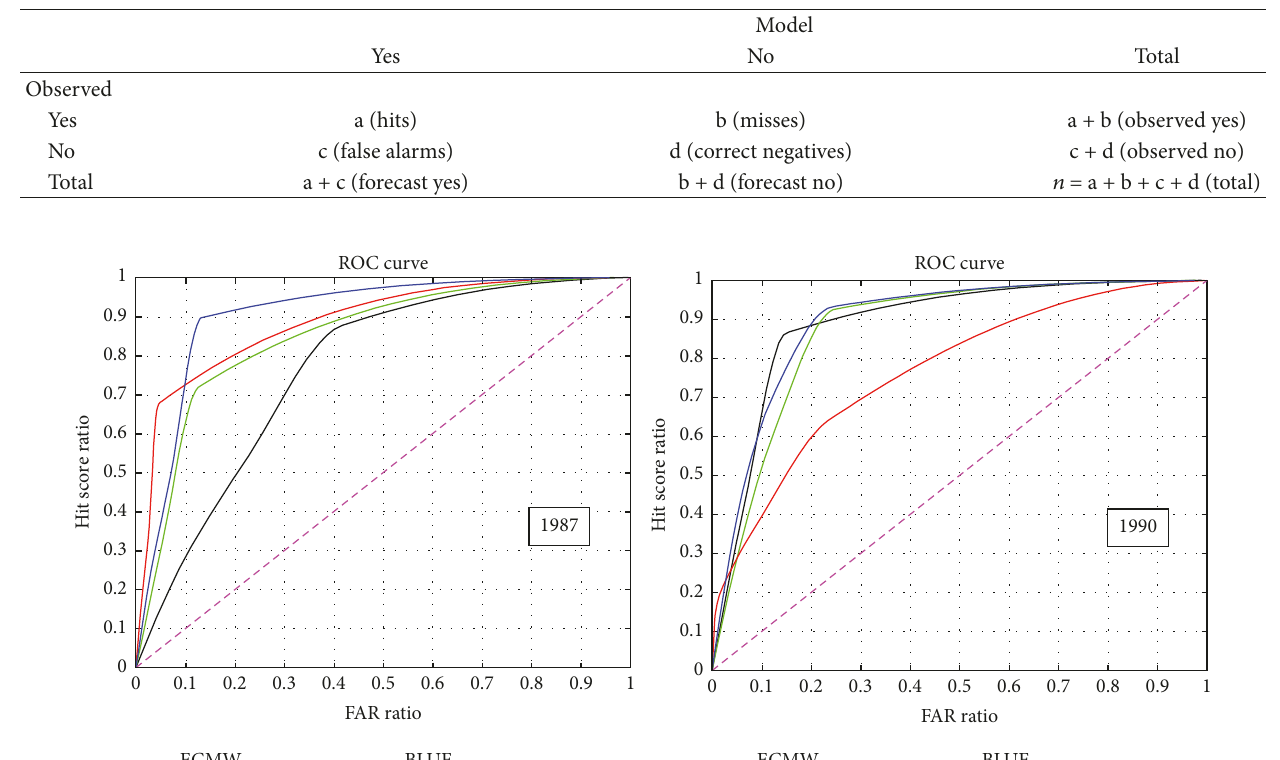
0.59, and − 0.25 to 0.52. On the other hand, ECMWF has the range from − 0.35 to 0.49 only. Clearly the improvement is not much, but for rainfall anomalies, surely it is appreciable. While, in case of RMSE, EM has a range from 1.41 to 2.78, SSE has the range from 1.48 to 2.79 and BLUE has the range from